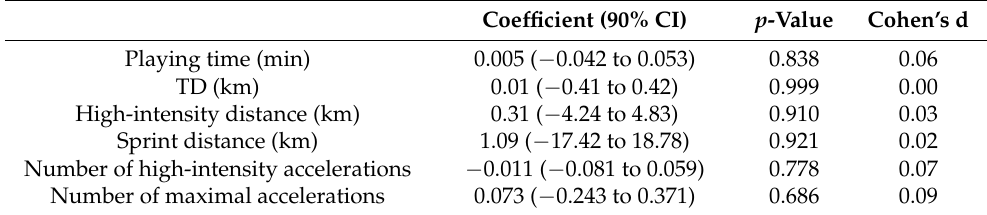
Table 4. Effects of playing time and physical performance on s-Cort differences calculated between 48-h post-match and 60-min before kick-off time points. Coefficient (90% CI) p -Value Cohen’s d Playing time (min) − 0.029 ( − 0.065 to 0.007) 0.193 0.35 TD (km) − 0.30 ( − 0.62 to 0.01) 0.116 0.41 High-intensity distance (km) − 3.54 ( − 7.02 to − 0.11) 0.097 * 0.38 Sprint distance (km) − 15.55 ( − 29.06 to − 2.06) 0.063 * 0.43 Number of high-intensity accelerations − 0.0056 ( − 0.1098 to − 0.0035) 0.086 * 0.40 Number of maximal accelerations − 0.236 ( − 0.462 to − 0.009) 0.091 *